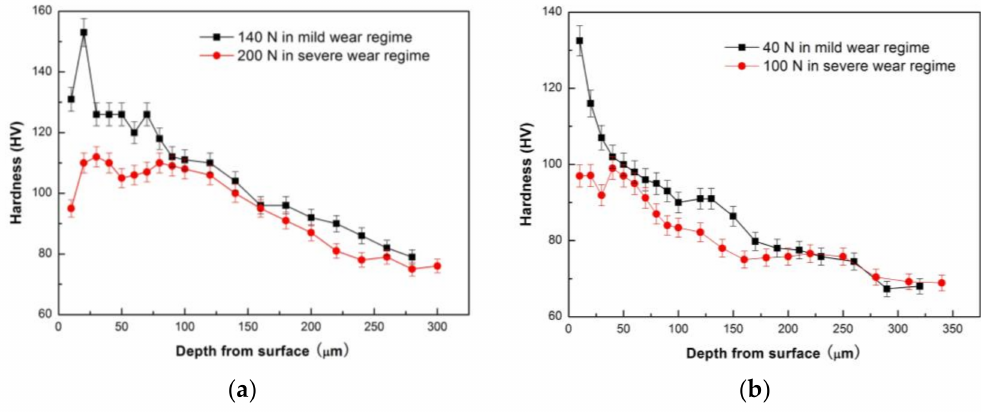
Figure 10. Variations in hardness with depth from the worn surface for Mg97Zn1Y2 alloy sliding at 0.8 m/s ( a ) and 3.0 m/s ( b ) before and after mild–severe wear